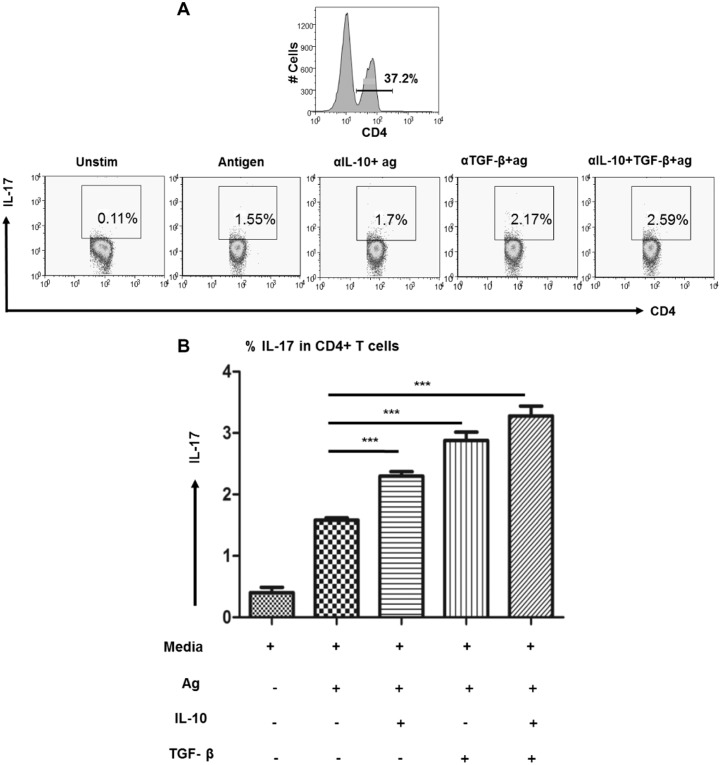
IL-10/TGF-β suppresses Th17 in BL/LL.A) Flow cytometric analysis showing the increased production of IL-17 on total gated CD4+ T lymphocytes in a leprosy patient with LL under different conditions, Unstimulated vs. Stimulated with leprosy antigen only vs. Stimulated with antigen and blocked with antibodies against IL-10/TGF-β alone or in combination. B) Cumulative data of BL/LL (n = 5) patients are shown in the bar graphs with the same conditions as above. Readout was taken in terms of IL-17 by CD4+ T cells at the end of 72 h. Mean with SEM are shown in each bar while P value< 0.05 was considered to be significant. Total number of cells analyzed by flow cytometry were 500,000. Data analysis was performed with flowjo software. Statistical analysis was done using Student’s t test for unpaired samples.